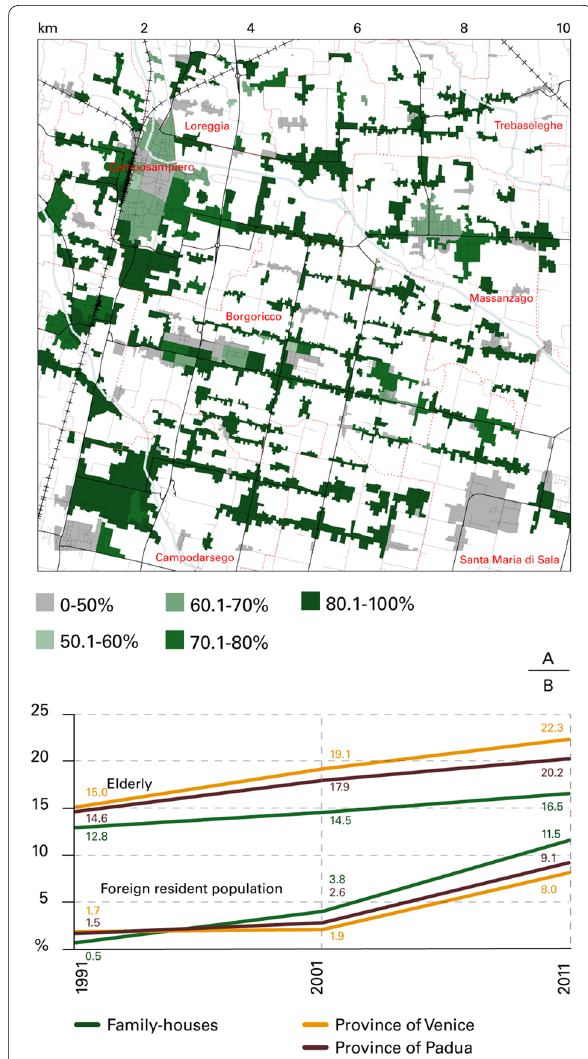
Fig. 8 a Central Veneto, 10 10 km sample. Percentage of one- and × two-interior buildings built in the period 1961–1991 out of the total residential stock at 2011 (authors’ calculations on data from Istat census). b Central Veneto: trends in the elderly and foreign population within the census blocks where family houses constitute more than 50% of the housing stock (authors’ calculations on data from Istat